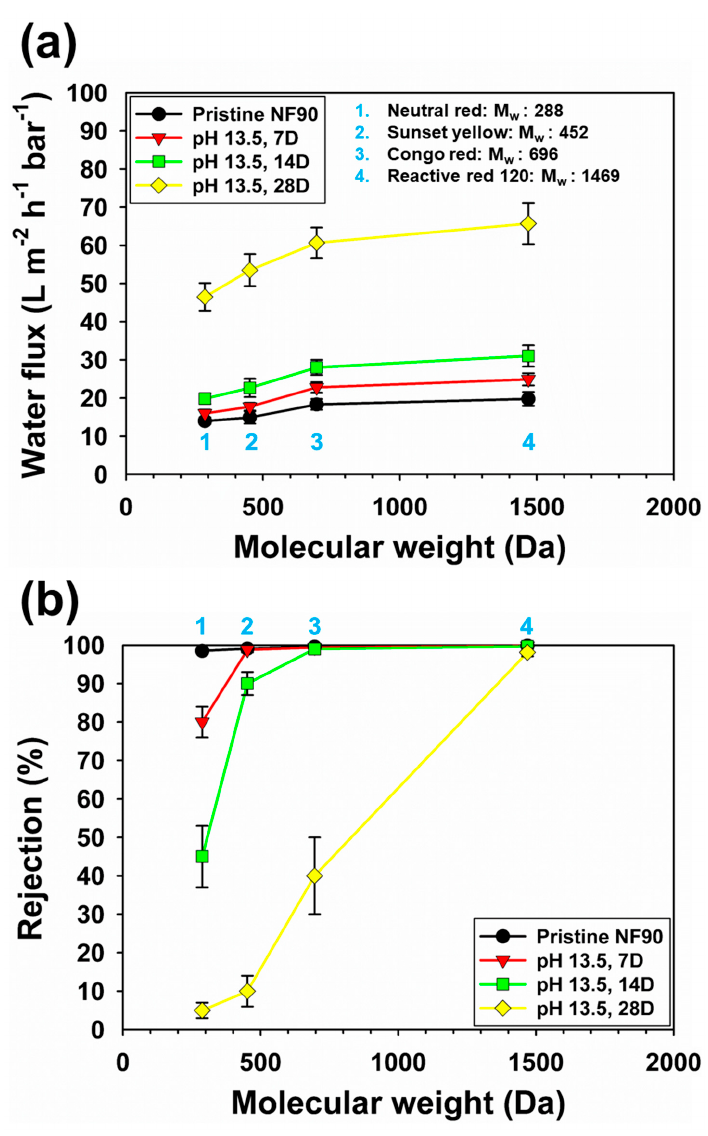
Figure 6. Effect of alkali hydrolysis on the permeability of NF 90 pristine and post-treated membranes in terms of ( a ) water flux and ( b ) dye rejection (experimental conditions: 50 mg L − 1 dye solutions and 5 bar).